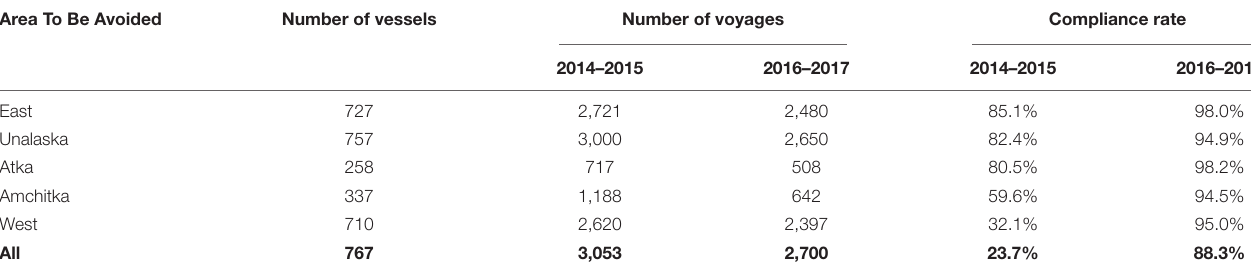
TABLE 2 | Individual vessel behavior changes, pre- and post-implementation of Aleutian Areas To Be Avoided (ATBAs). Area To Be